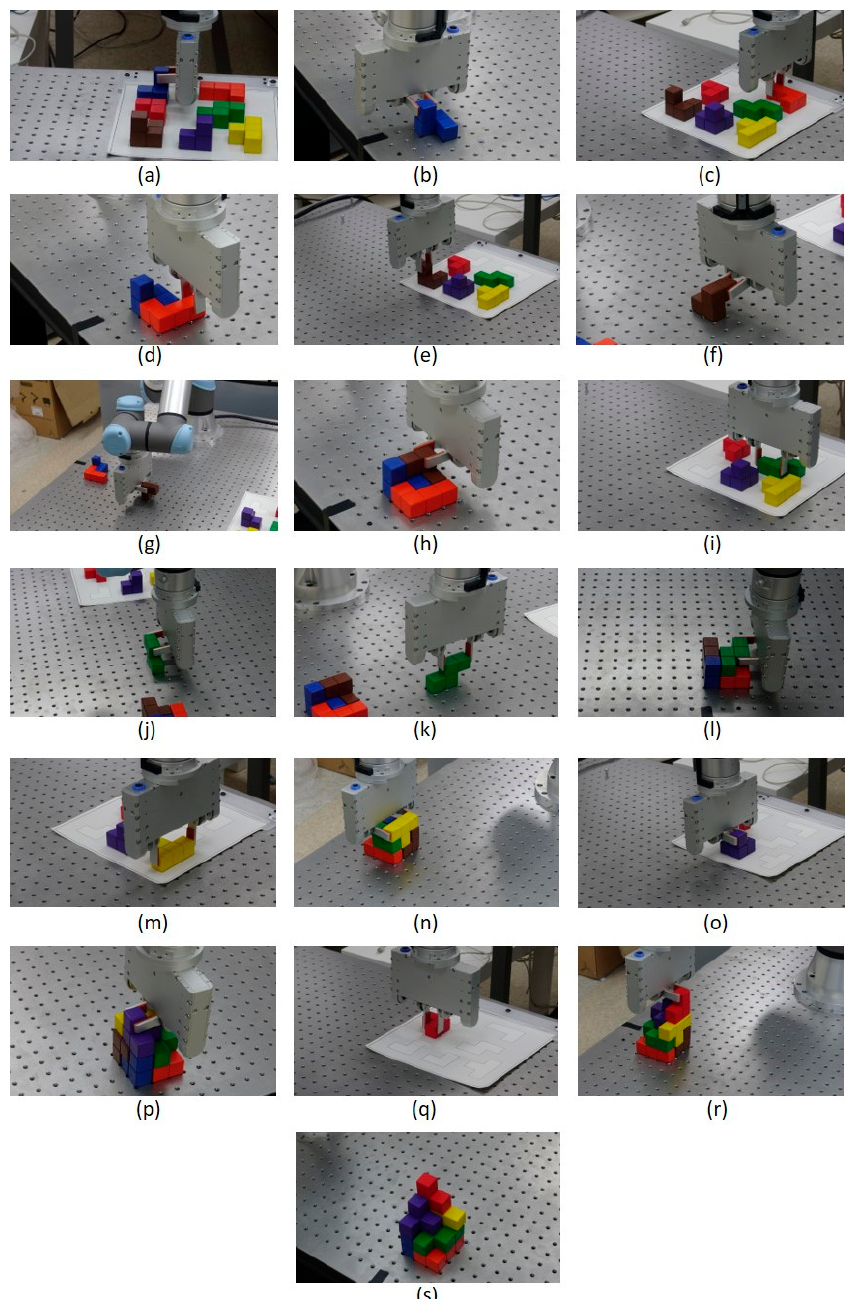
Figure 9. Soma puzzle assembly in formation 1 (shown in ( s )). From ( a – r ) the figures show the snapshots of the grasping and assembly poses of the gripper and part during the assembly process. Figures ( e – h ) and ( i – l ) shows the part manipulation through intermediate poses of parts.